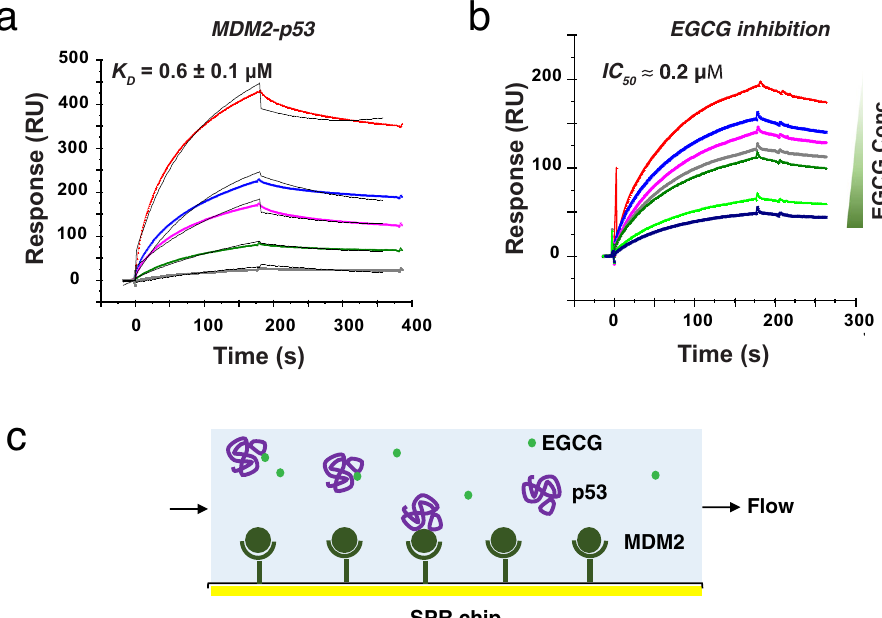
Fig. 5 EGCG inhibits MDM2 – p53 interaction with a sub-micromolar IC 50 . a SPR sensorgrams and binding af fi nity of full length p53 − MDM2 interaction. Concentrations of the full-length p53 (from top to bottom) were 2000, 1000, 500, 250, and 125 nM, respectively. The black curves are the fi t curves using models from BIAevaluation 4.0.1. Chi 2 = 31. b SPR sensorgrams of full length p53 − MDM2 binding in the presence of different concentrations of EGCG in solution. Concentrations of EGCG (from top to bottom) were 0, 31.25, 62.5, 125, 150, 300, and 500 nM, respectively, while concentration of p53 remained at 250 nM. Source data are provided as a Source Data fi le. c Experimental setup for SPR competition. When EGCG binds p53 in solution, less p53 is available to bind MDM2 on the chip, reducing SPR signal.